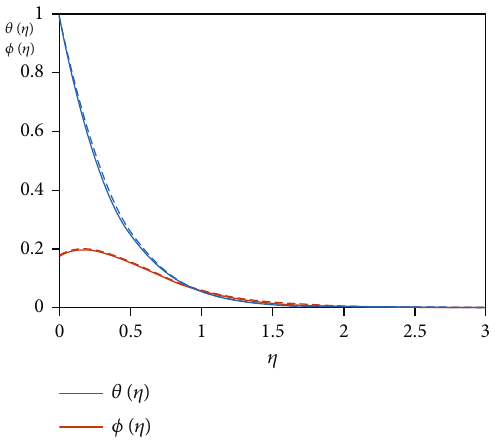
Figure 2: Concentration and temperature pro fi les a ff ected by magnetic fi eld